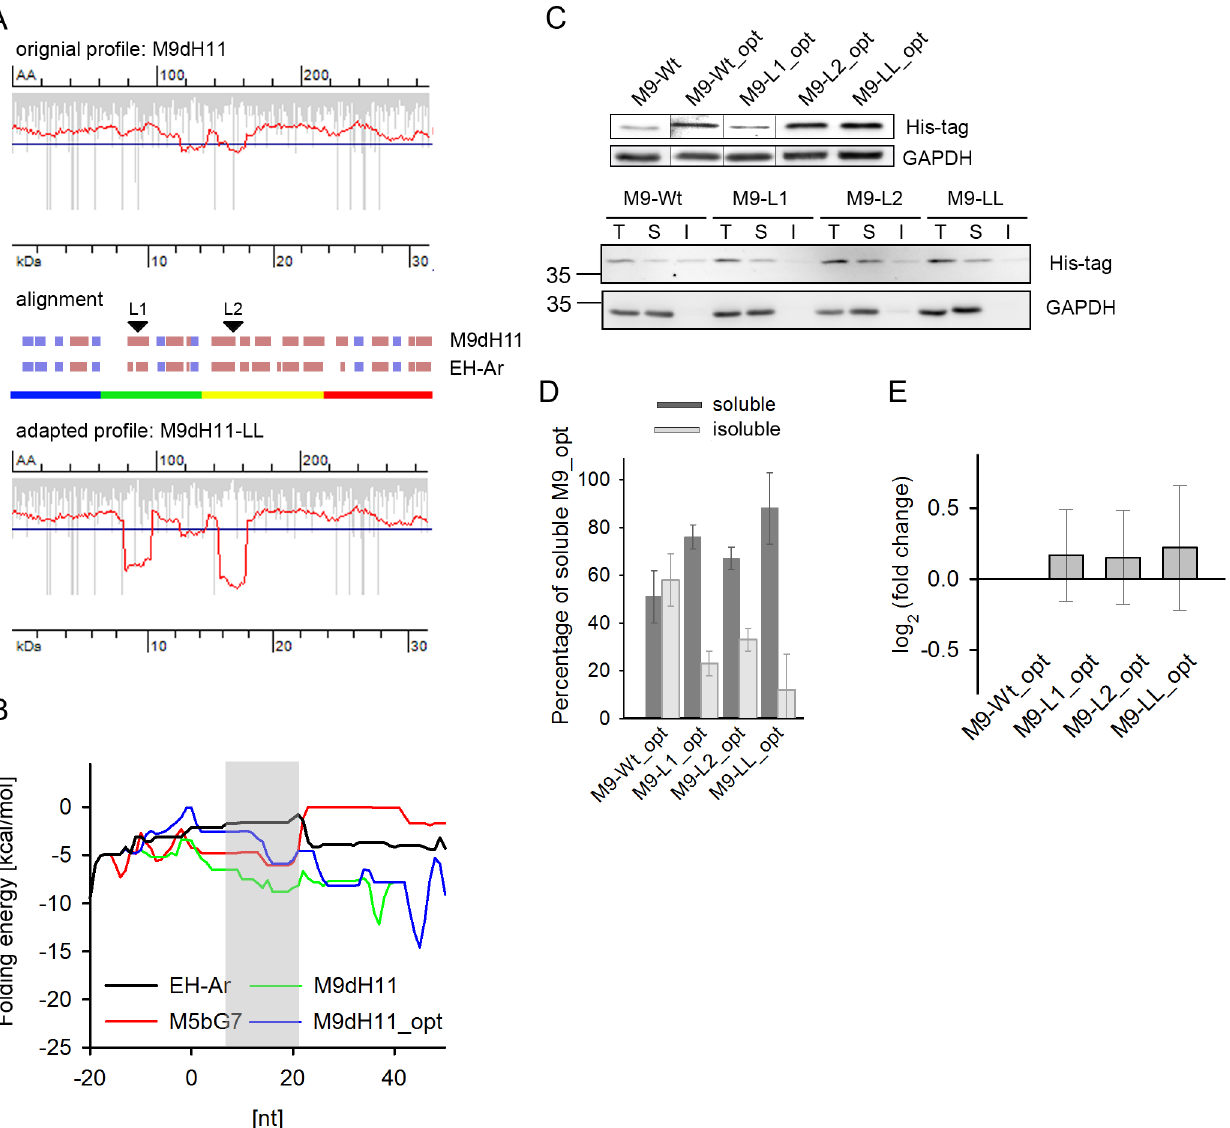
Fig 3. Introducing translational attenuation sites into the EH M9dH11 sequence enhances its solubility. (A) Translation profile of wild-type M9dH11 (top diagram, original profile) and upon introduction of translational attenuation sites (bottom diagram) in E . coli . Secondary structure alignment ( β -sheets — blue bars, α -helices — dark red bars, uncolored empty space — linking structural elements) of M9dH11 to EH-Ar to identify regions for introduction of slow- translating stretches (indicated with arrows). The domains in M9dH11 were delineated based on the EH-Ar domain architecture presented in the color code used in Fig 1A. (B) Local folding energies of the mRNA sequences of EH variants around the start codon. The zero nucleotide position corresponds to first nucleotide of the start ATG codon. The shadowed area marks the codons (3 rd to 7 th ), at which changes were undertaken in M9dH11_opt. The -50 nucleotides for all four sequences are identical and determined from the upstream region of the expression vector. For comparison, two EH variants, EH-Ar and M5bG7, with lower folding energies than that of M9dH11 are included. The energy of M9dH11_opt falls between that of EH-Ar and M5bG7. (C) Representative immunoblot (n = 3) of total expression (upper panel) of M9dH11 (abbreviated M9) variants and fractionation to soluble and insoluble fractions (bottom panel). M9_opt denotes the variants with optimized secondary structure at the 5 ’ -end. L1 (Leu 88, CUG/A, numbering is according to the M9dH11 sequence), L2 (Leu154, CUG/A) and LL (Leu88, CUG/A, Leu154, CUG/A) denote synonymous exchange of a fast-translating Leu codon to Leu CUA in the first, second or both attenuation sites (LL), respectively. T, total protein, S, soluble and I, insoluble fraction. GAPDH served as loading control. For details refer to the legend to Fig 1. (D) Quantification of immunoblots of two biological replicates ± SD. (E) Quantification of mRNA levels by qRT-PCR of the M9dH11_opt variants. Values were normalized to GAPDH mRNA expression, represented as a fold-change to the wild-type mRNA and are means ± SEM (n =